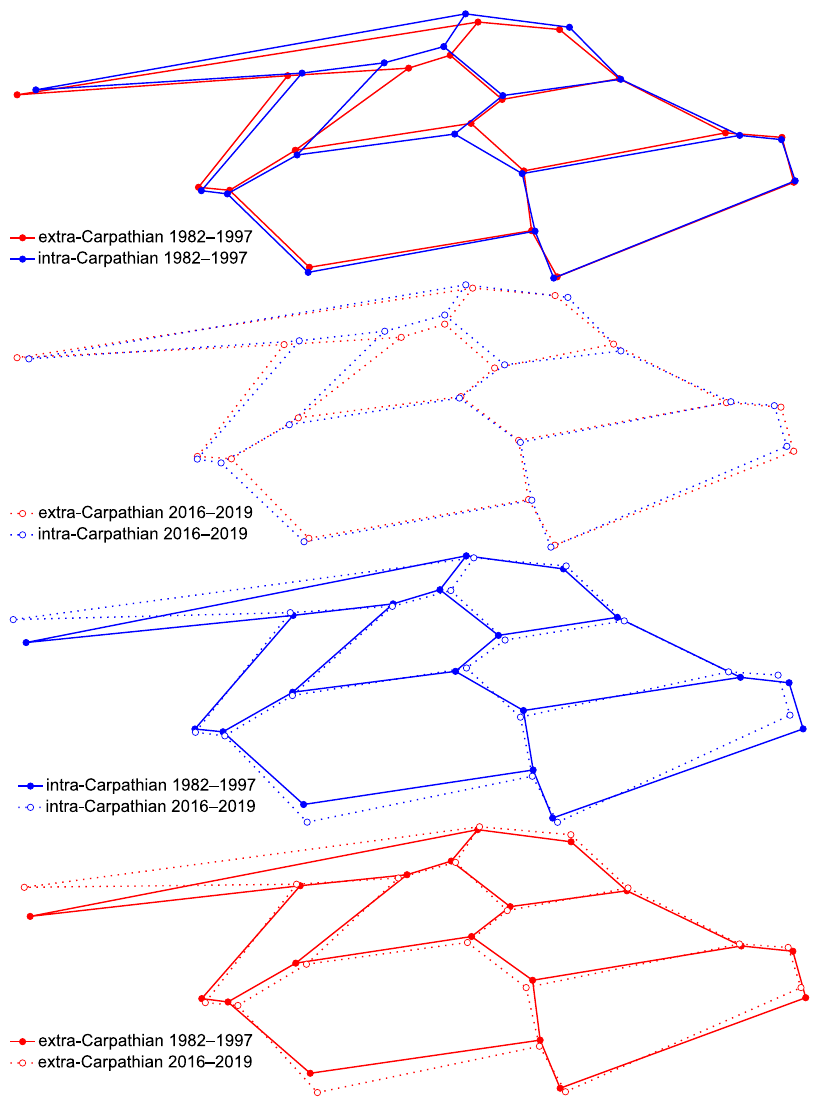
Figure 3. Differences between the intra- and extra-Carpathian groups of samples collected in the years 1982–1997 and 2016–2019. The differences were increased by 5-fold.